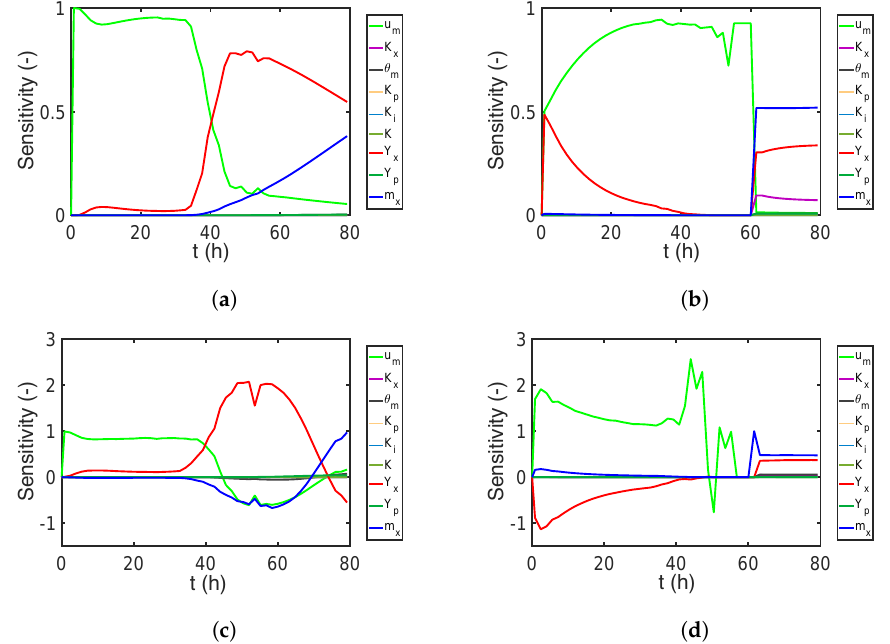
Figure 13. Sensitivity results of the nine parameters on the biomass and substrate concentrations for the independent case: ( a ) first-order sensitivity indices for the concentration of biomass X ; ( b ) first-order sensitivity indices for the concentration of substrate S ; and correlated case ( c ) total covariance-based first-order sensitivity indices for biomass X ; ( d ) total covariance-based first-order sensitivity indices for substrate S .